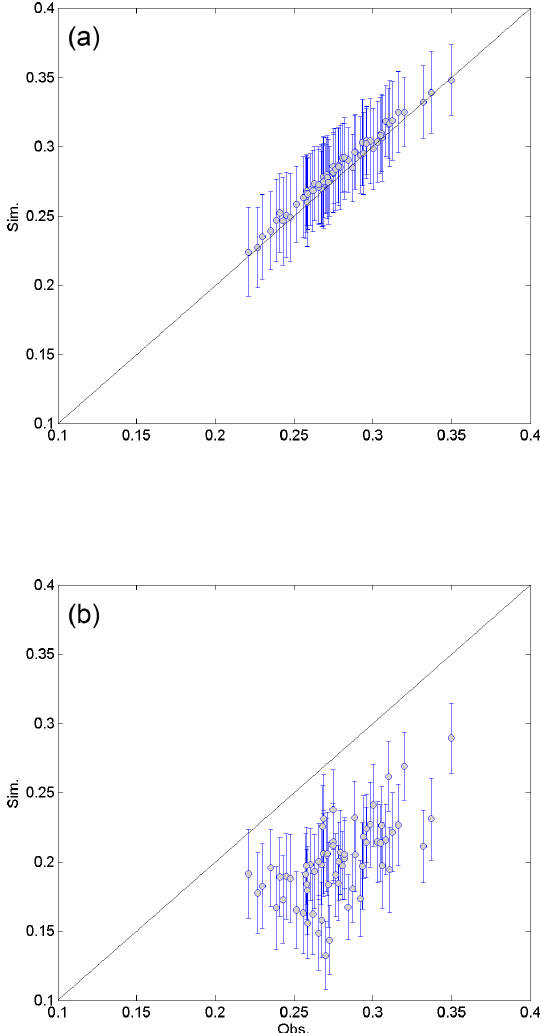
Figure 9. Scatterplot of lag-1 cross-correlations between 12 weather stations for the observed data ( x coordinate) and the generated data ( y coordinate) from the DKNNR model (a) and the MONR model (b) . The cross-correlations from 100 generated series are averaged for the filled circle, and the error bars upper and lower extended lines indicate the range of 1.95 times the standard